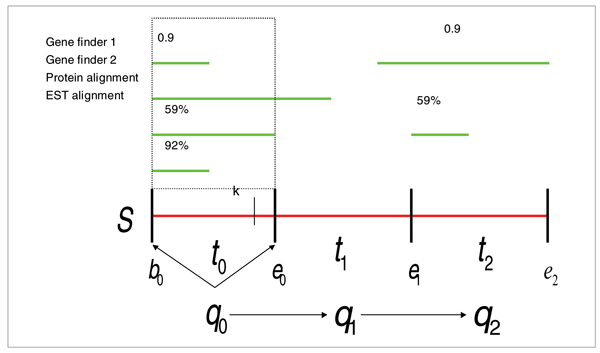
Parsing sequence S into three non-overlapping intervals t0, t1 and t2 with the state assignments q1, q2 and q3, respectively. Position k marks an index in S. The dashed box highlights the evidence overlapping the first interval from position b0 to e0.